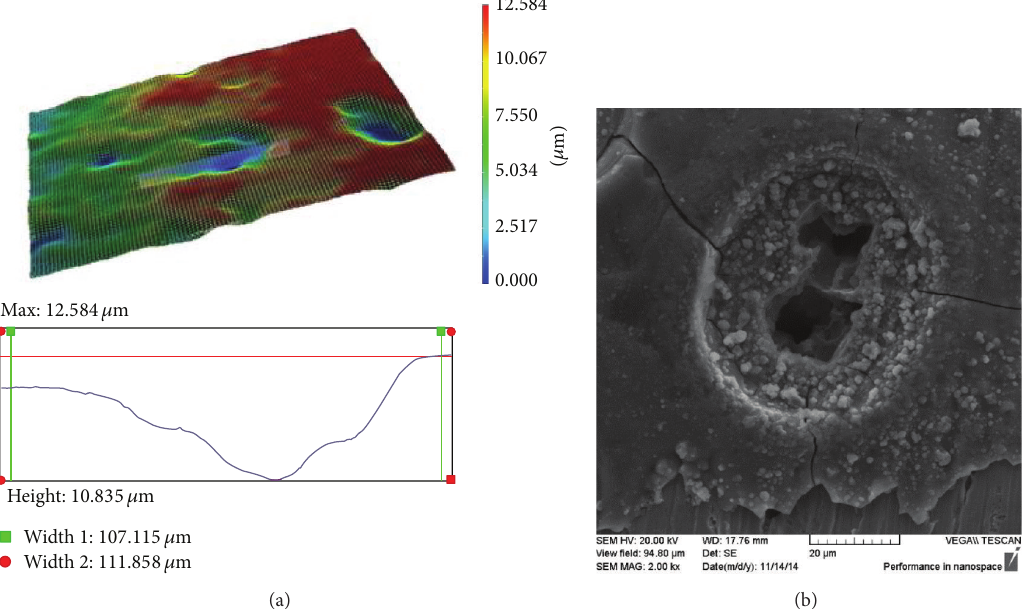
Figure 8: Corrosion morphologies of ductile cast iron corroded in stagnant simulated cooling water (10,000 ppm NaNO 2 ) for 3 hours at 25 ∘ C; (a) 3D microscope and (b) SEM